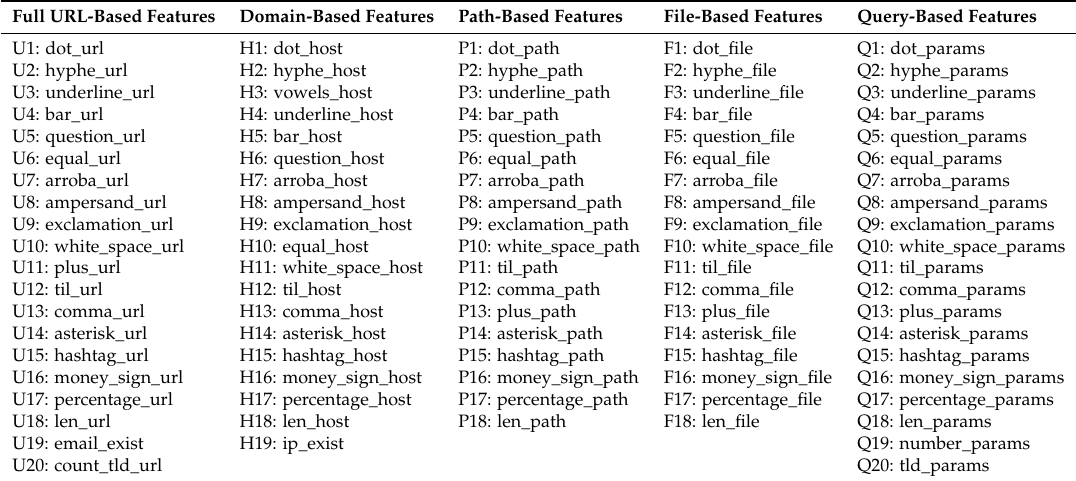
Table 2. List of hand-crafted features.